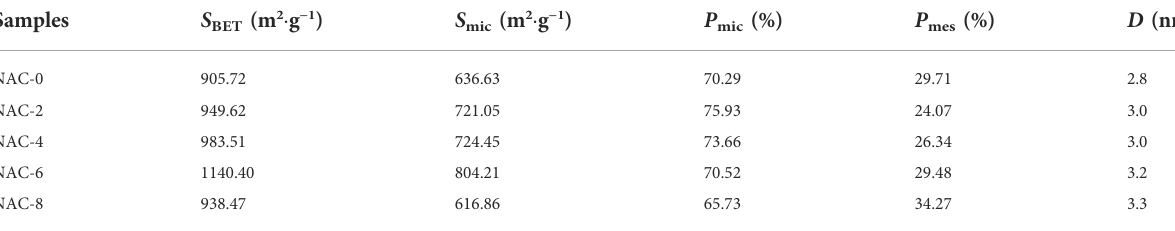
TABLE 1 BET surface areas and pore size distributions of the as-prepared AC samples.